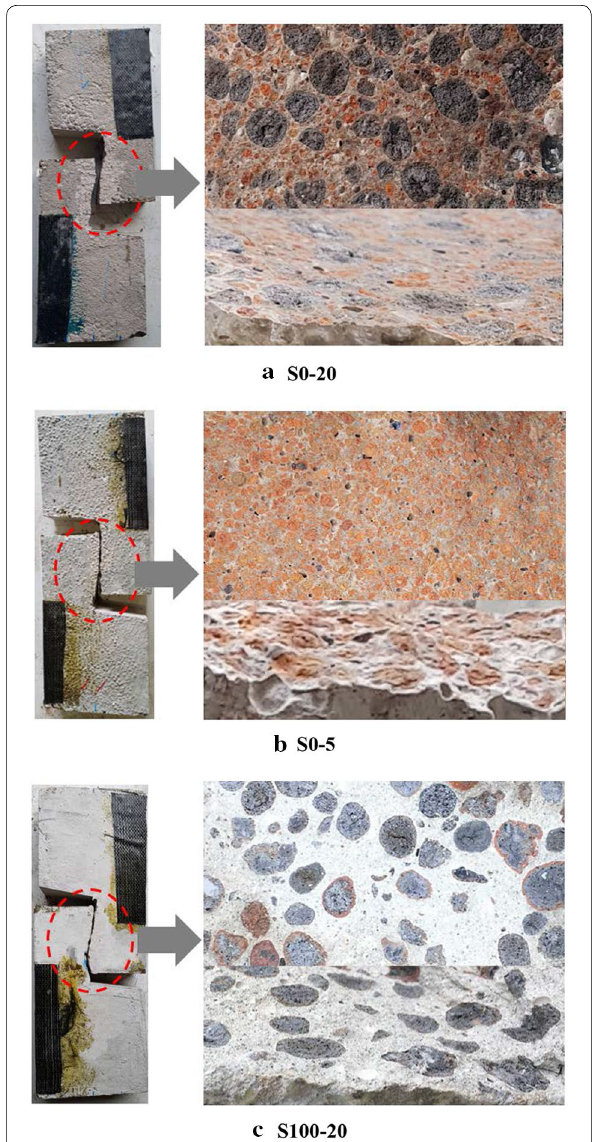
Fig. 1 Typical failure plane of push‑off specimens (in series III): a S0‑20; b S0‑5; c S100‑20.